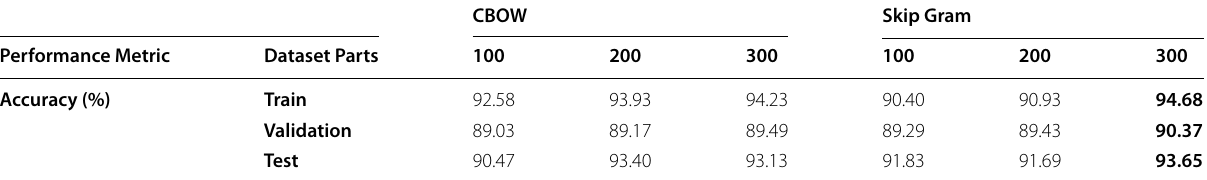
Table 8 Accuracy values of the proposed model